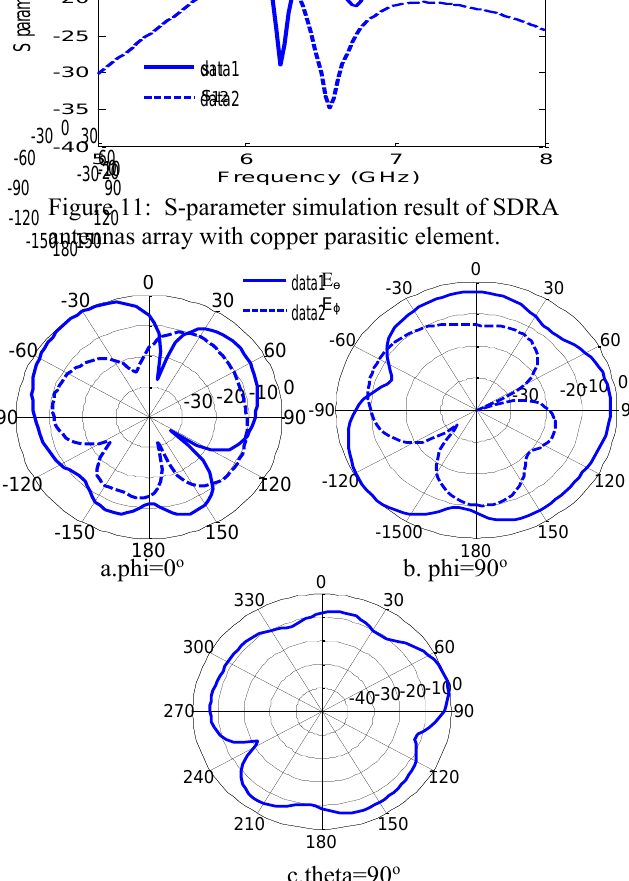
Figure 12: Radiation pattern of two SDRA antennas at frequency 6.56 GHz.